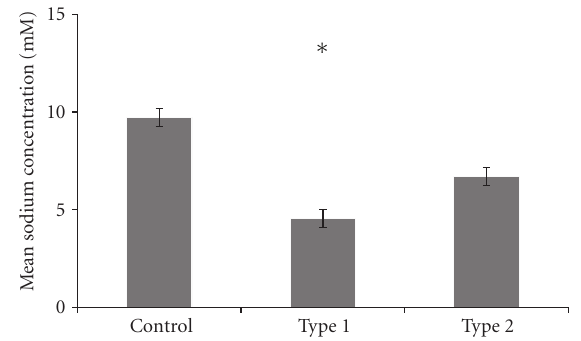
Figure 4: Mean glucose content of milk in each group. ∗ indicates significant di ff erence ( P < 0 . 05) compared to control